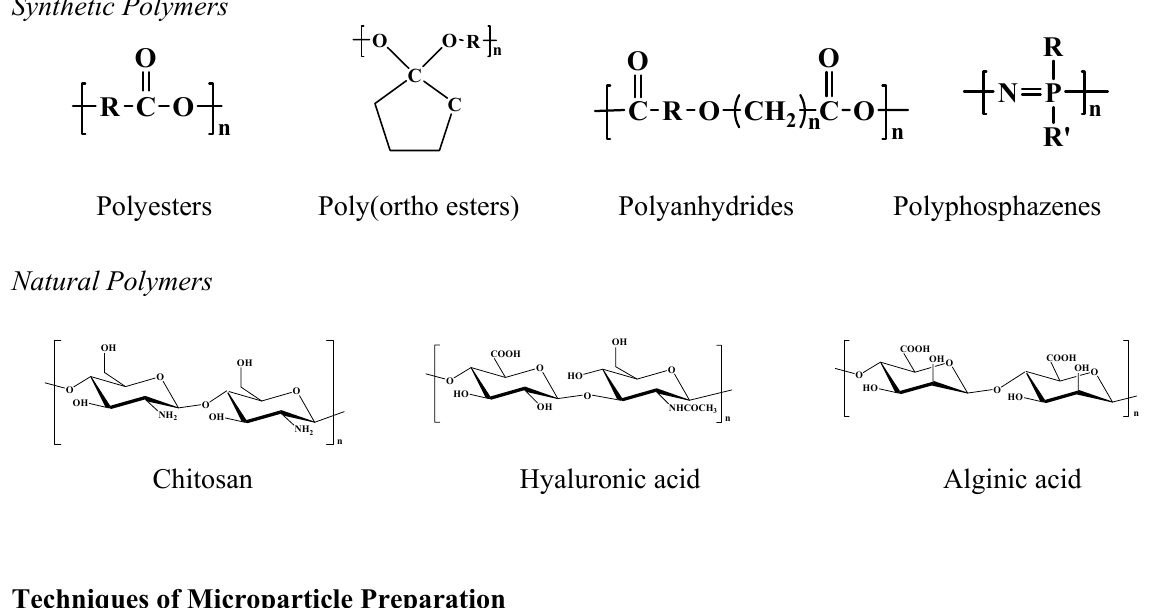
Figure 1. Chemical structures of several biodegradable